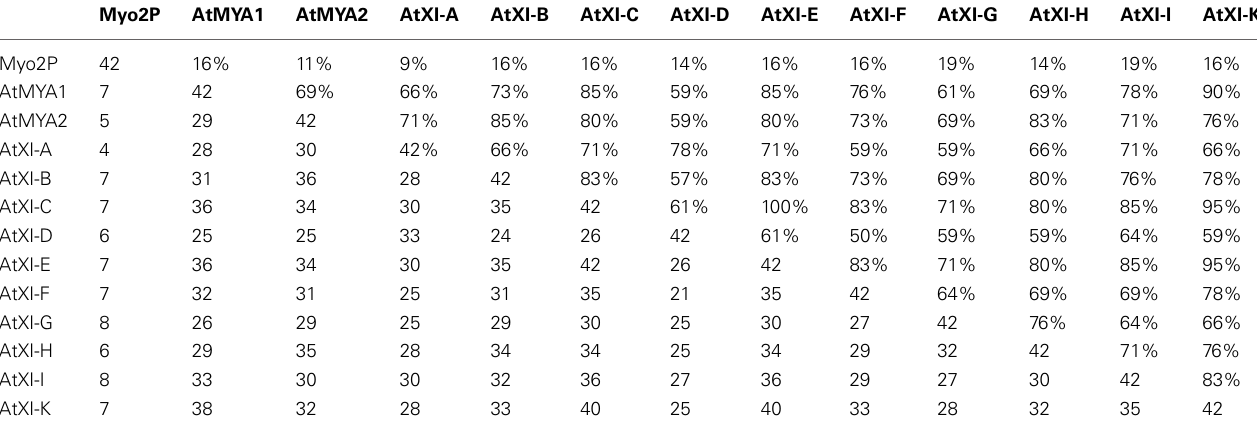
Table 2 | Pairwise comparison of the amino acid sequences of the PAL sub-domain from A. thaliana class XI myosins and vacuole binding site in the yeast class V myosin Myo2p.